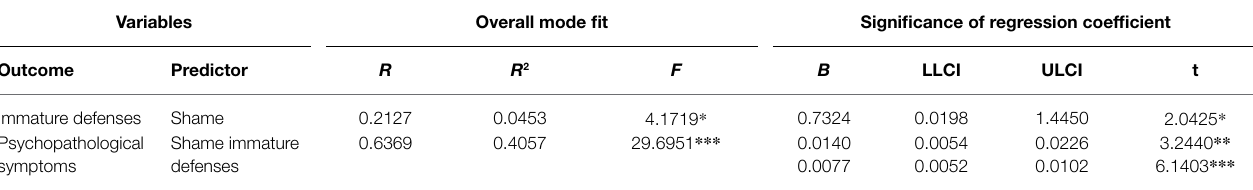
TABLE 4 | Mediation model of the mediating role of immature defenses in the relationship between shame and psychological distress.